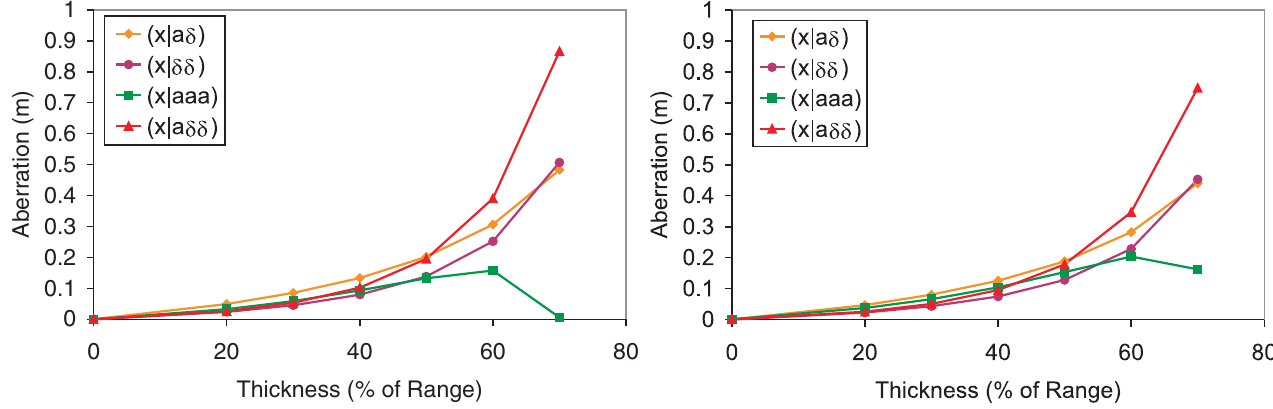
FIG. 3. (Color) Effects of not shaping the degrader: large second and third order aberrations are generated at the no-wedge achromatic image at 200 (left) and 400 (right) MeV = u